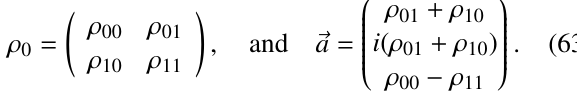
Figure 1: Action of a depolarizing channel on the Bloch ball. The Bloch ball (outer ball of unit radius) is shown in white. The image is plotted in red.